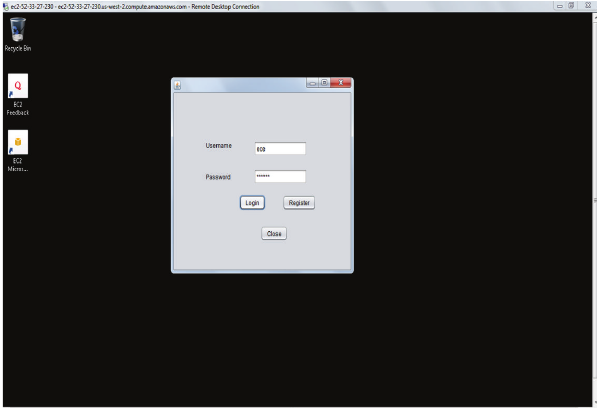
Figure 3: Application run on remote machine.